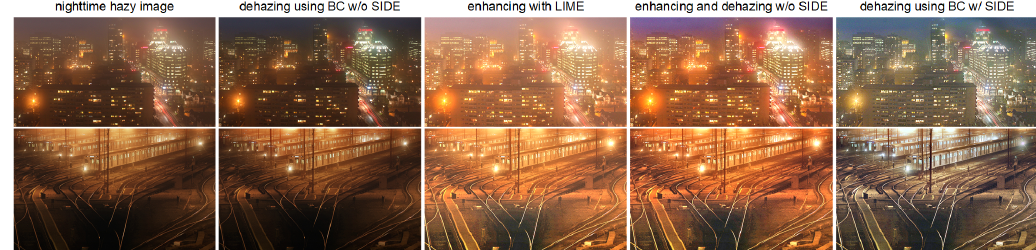
Figure 7. Comparisons of conventional dehazing methods and low-light enhancement methods. From left to right: observed nighttime hazy images, dehazing results using BC [4] directly, enhancement results using LIME [17], dehazing results after enhancement, dehazing results using BC with the proposed